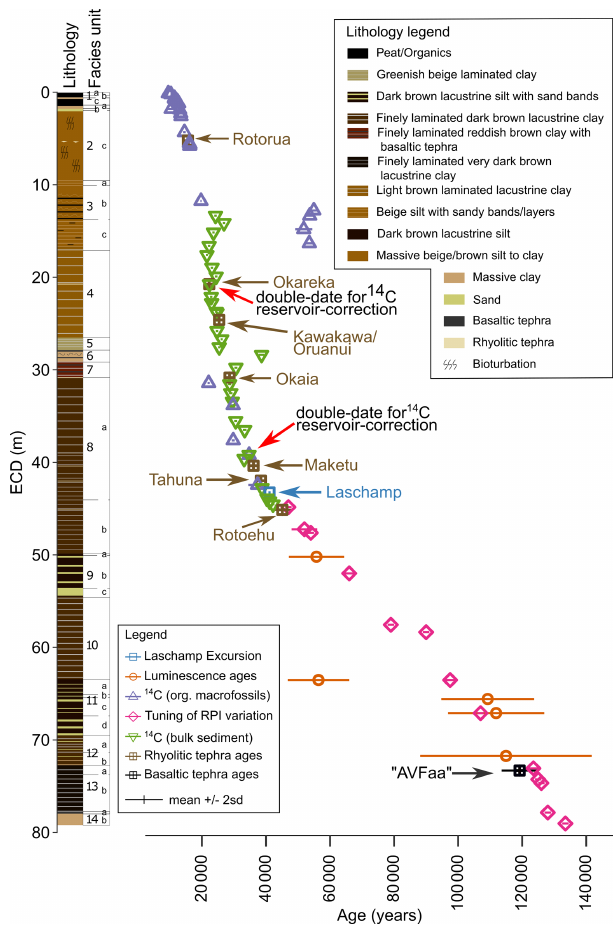
Figure 9. Simplified lithology and summarised facies units of the Orakei sediment sequence (from Peti and Augustinus, 2019) with ages ( ± 2 σ ) used in the current chronology study (identified tephras marked with names – for published and adjusted (this study) ages see Table 2). Red arrows mark double dates undertaken for 14 C reservoir correction (see Sect. 3.2). Note that radiocarbon dates have been calibrated and reservoir-corrected where applicable as noted